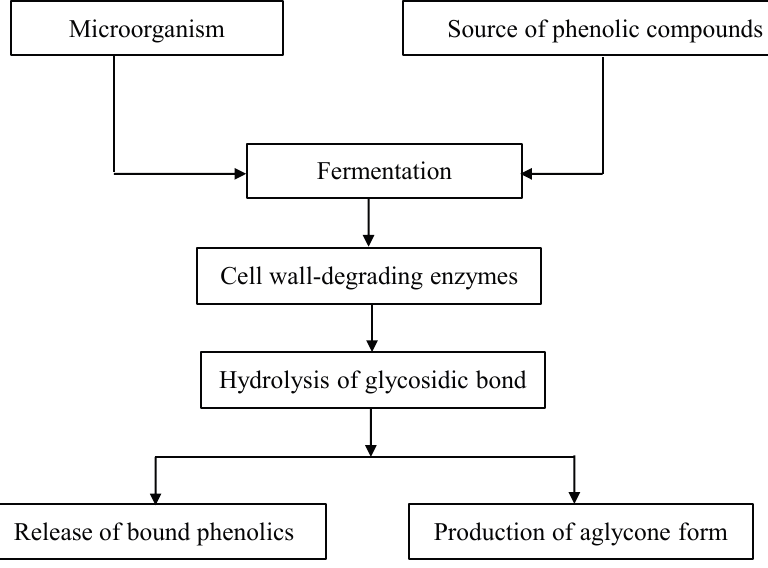
Figure 1. A schematic diagram of the release and bioconversion of phenolic